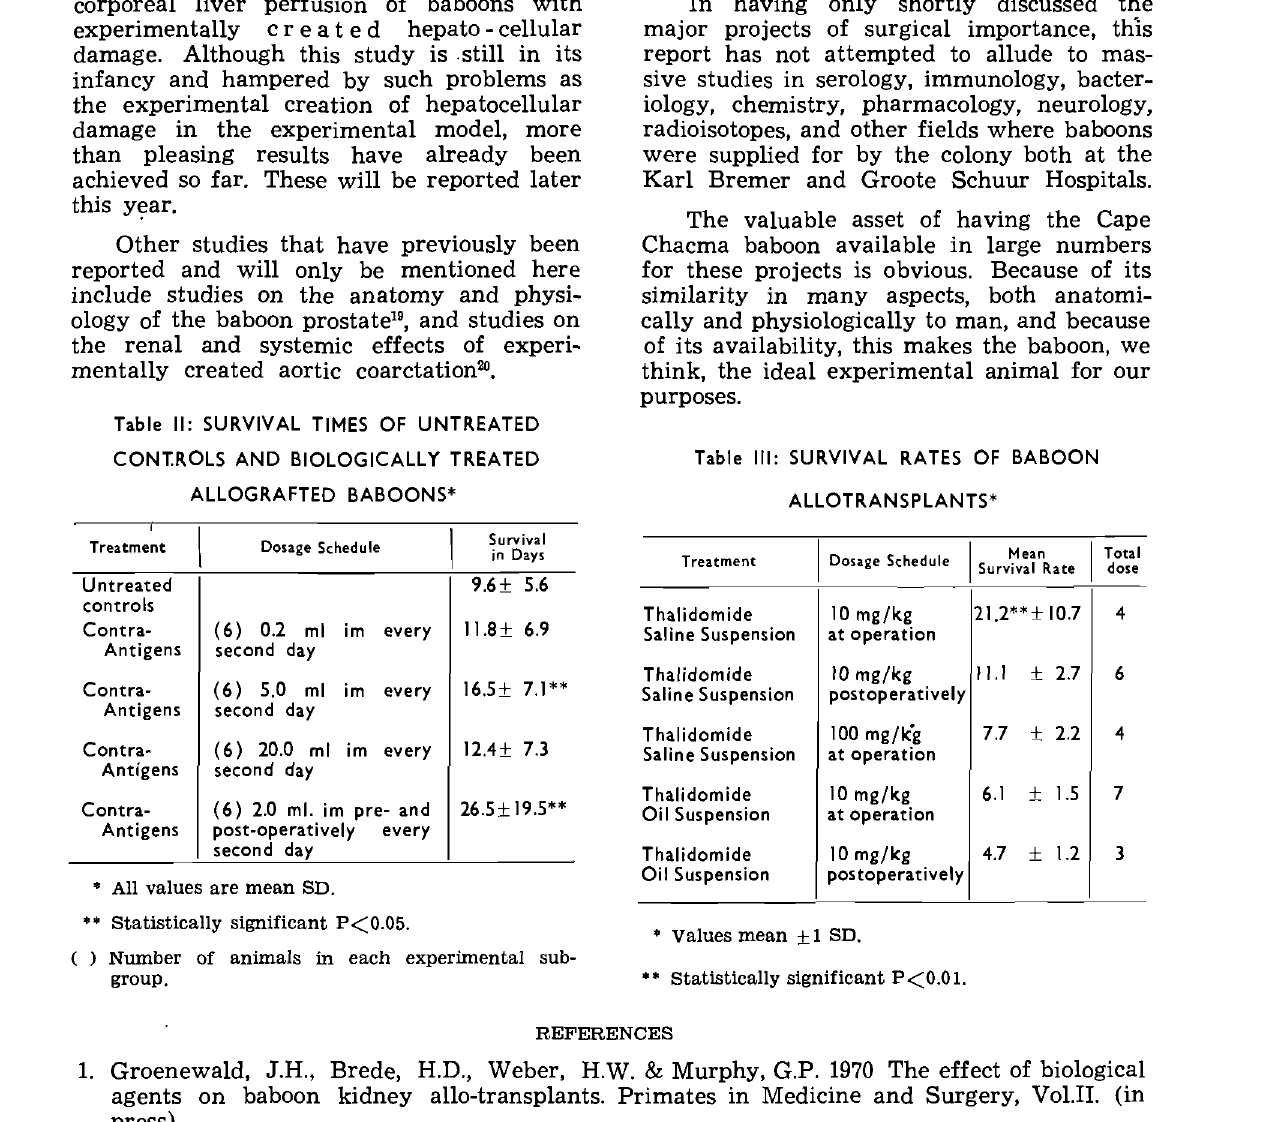
Table III: SURVIVAL RATES OF